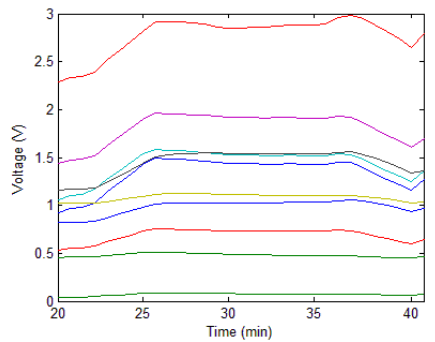
Figure 12. Pre-processing result of the E-nose response data to the air in the bulk curing barn.